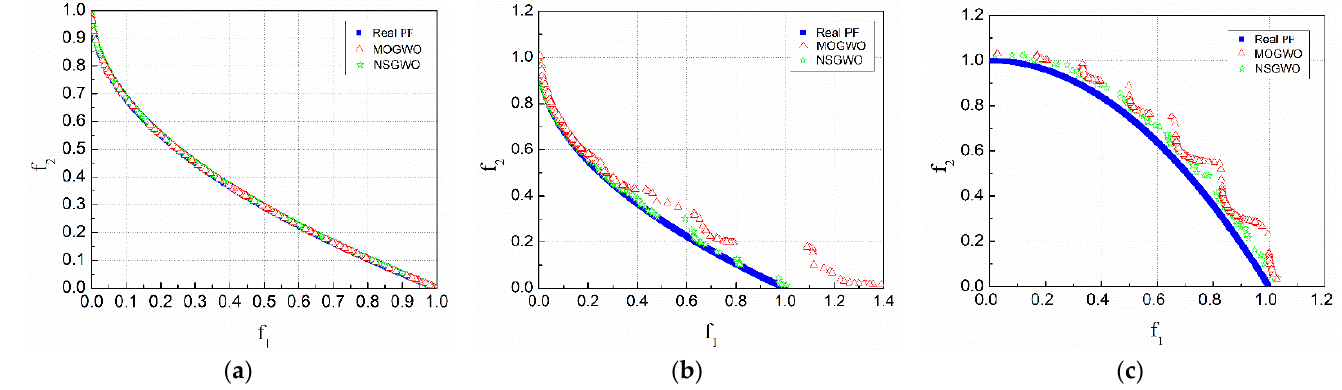
Figure 3. Pareto fronts of multiobjective optimization algorithms for benchmark functions. ( a ) ZDT1; ( b ) UF2; ( c ) UF4.